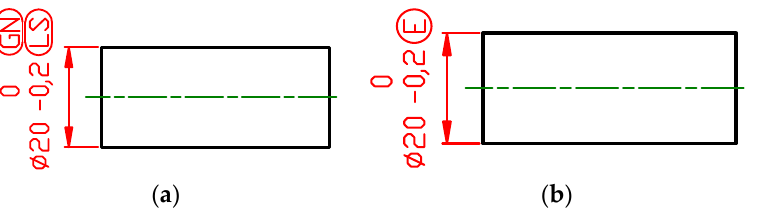
Figure 2. ( a ) Shaft with limit sizes specified according to the ISO GPS system indications with requirements equivalent to those given in Figure 1a (ASME Y14.5); ( b ) the envelope requirement (ISO GPS) is not fully in line with requirements given in Figure 1a.